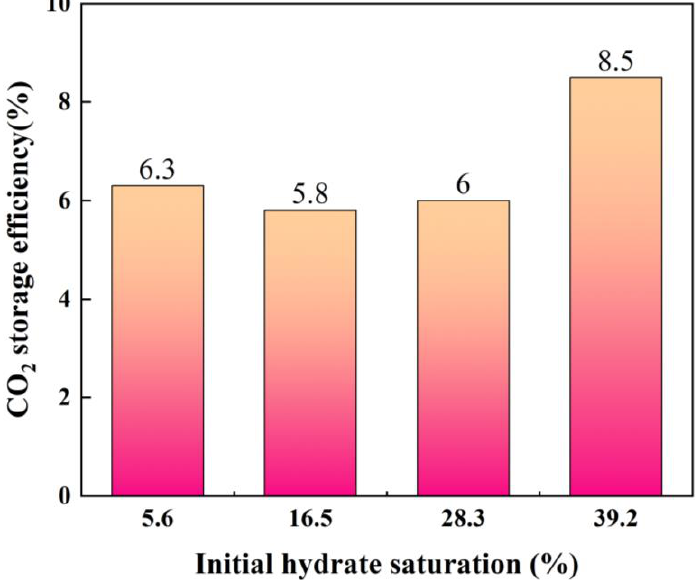
Figure 6. Storage efficiency of CO 2 in the replacement reaction in Experiments 5, 6, 7, and 8.